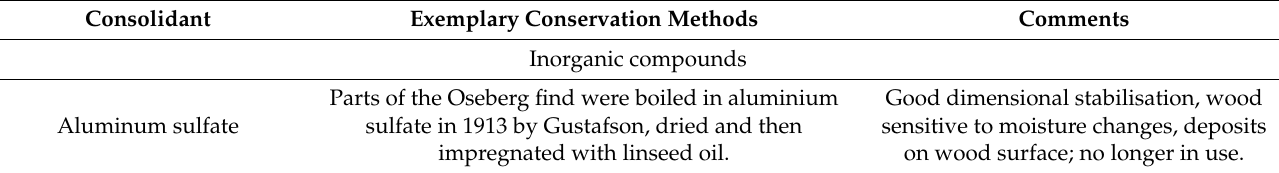
Table 1. A historical overview of waterlogged wood consolidants